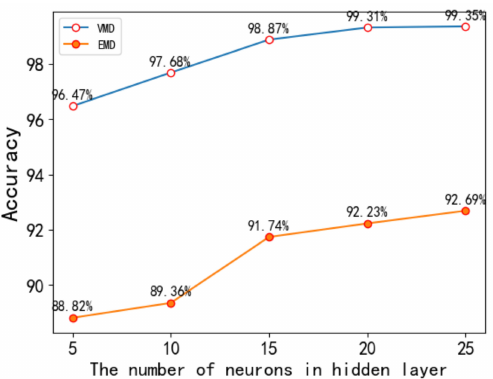
Figure 6. Classification accuracy of the VMD and EMD algorithms with different numbers of neurons in hidden layer.